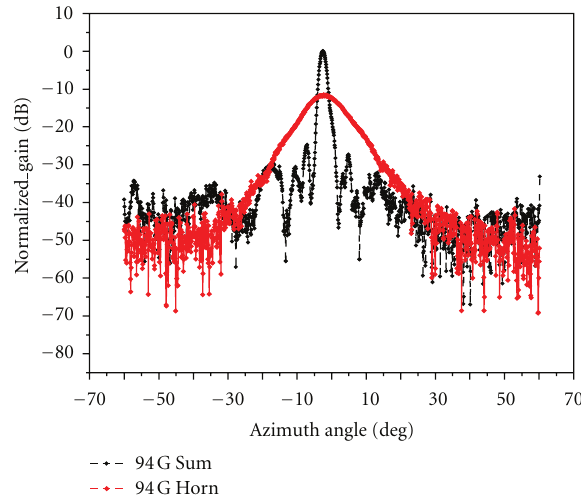
Figure 12: Antenna gain of sum signal and standard horn at